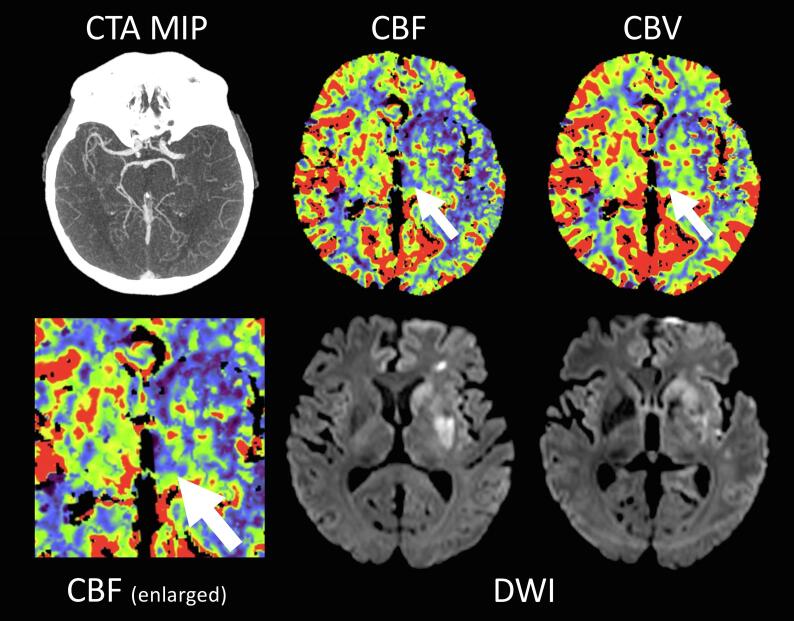
Example of a 74 year-old, male patient with left sided M1-occlusion (same as in Fig. 1). CTA presents proximal M1-occlusion on the left side with consecutive perfusion deficit in the left MCA territory on CTP. Additionally, marked thalamic hypoperfusion adjacent to the third ventricle is visible on the ipsilesional side (white arrows). Follow-up DWI after 6 days presents ischemic damage to the basal ganglia, but not to the thalamus. Also note absence of fetal PCA on CTA. Abbreviations: CTA, CT angiography; MIP, maximum intensity projection; CBF, cerebral blood flow; CBV, cerebral blood volume; DWI, diffusion weighted imaging; CTP, CT perfusion; PCA, posterior cerebral artery.